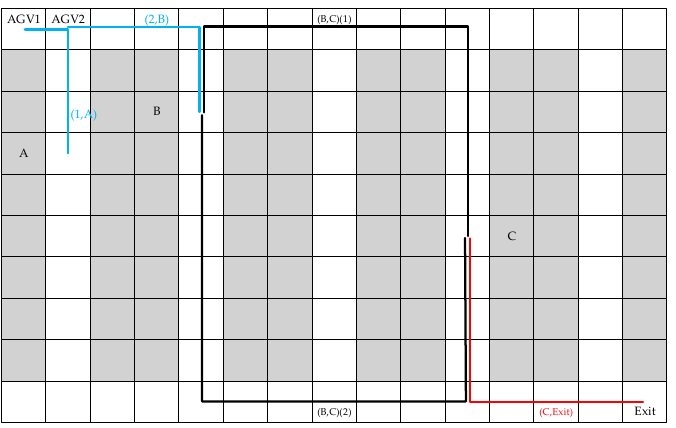
Figure 2. Examples of calculation method for the travel distance between pickup point (or entrance) i and pickup point (or exit) j (d ij ).